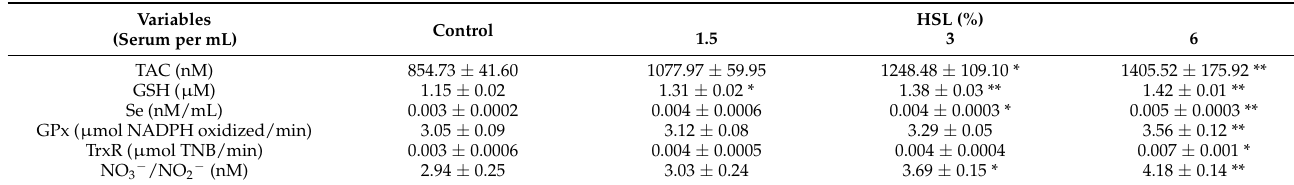
Table 2. Oxidative stress markers in serum in the rats of the experimental groups.